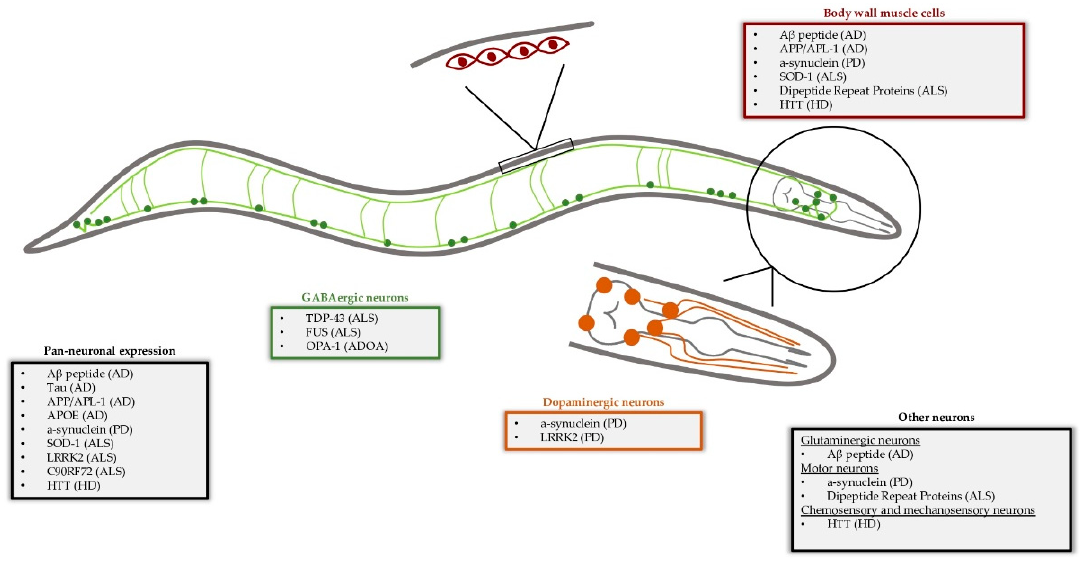
Figure 1. Examples of C. elegans models used to study neurodegenerative disorders by expressing human disease-associated genes in specific cell types. The GABAergic neurons are illustrated in green, and magnified are the body wall muscle cells (red) and the dopaminergic neurons (orange). AD = Alzheimer’s disease, PD = Parkinson’s disease, ALS = amyotrophic lateral sclerosis, HD = Huntington’s disease, ADOA = Autosomal Dominant Optic Atrophy.